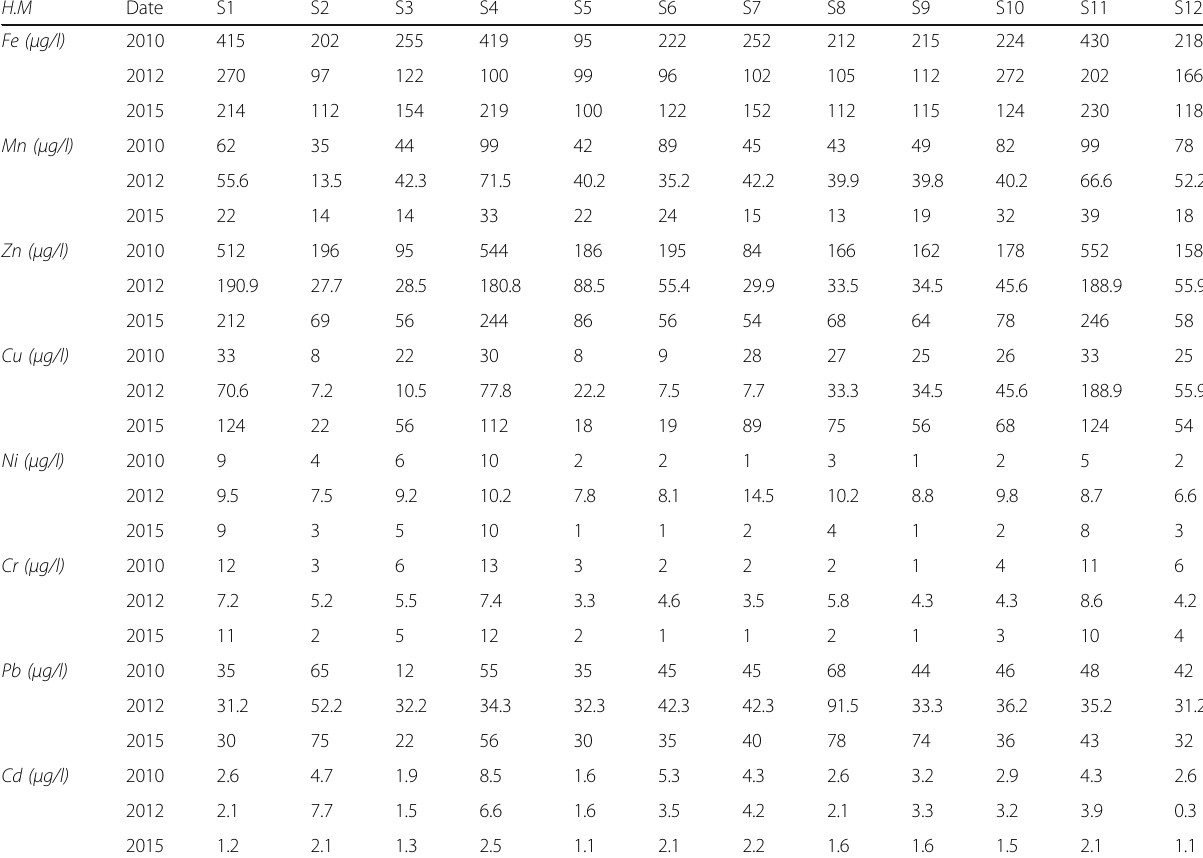
Table 7 Distribution of Fe, Mn, Zn, Cu, Ni, Cr, Pb, and Cd ( μ g/L) in water samples during 2012 – 2015 H.M